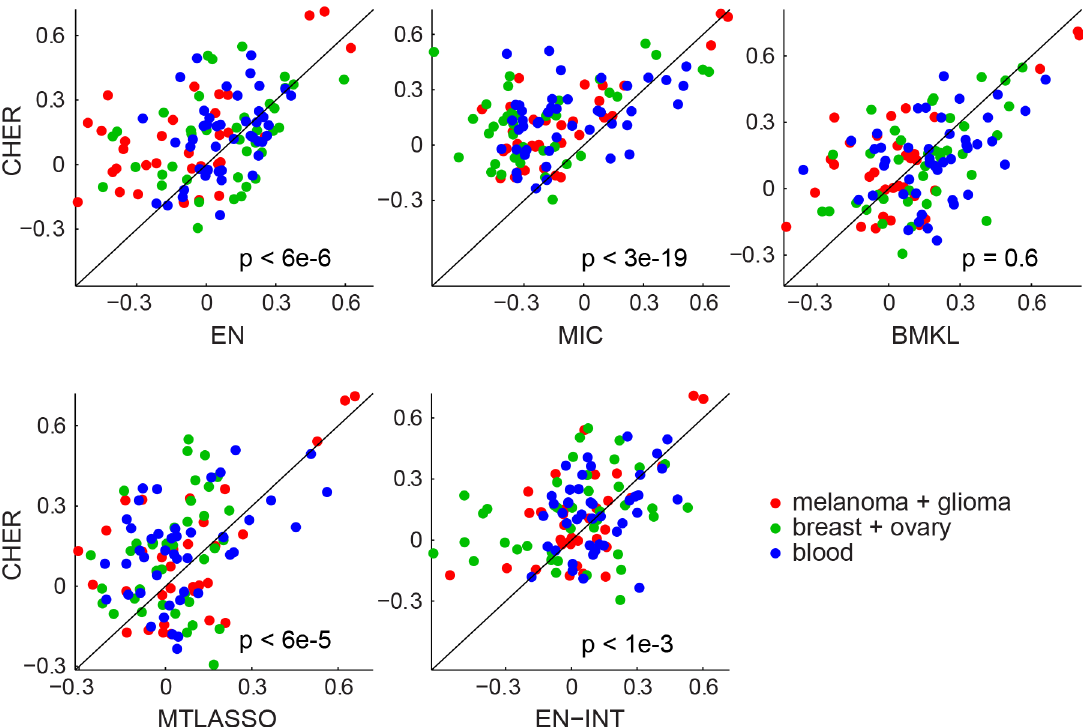
Fig 5. Comparison of CHER with other methods. Pearson correlation coefficients between the prediction and the sensitivity data are calculated for each algorithm. The correlation coefficients from each algorithm (x-axis) are compared to those from CHER (y-axis). Each dot represents prediction performance for one drug sensitivity. Method abbreviation: EN, the elastic net, MIC, multiple inclusion criterion; BMKL: Bayesian multi-task multi-kernel regression; MTLASSO: multi-task lasso; EN-INT: EN with context-gene interactions. P-values show the significance of CHER ’ s prediction compared to other methods (one-tail